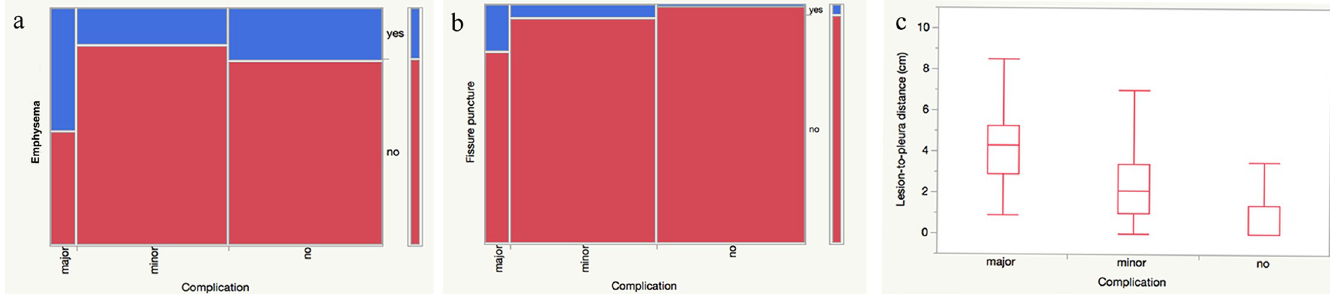
Fig 4. The independent risk factors for major complications in our study (n = 311). Mosaic plot of (a) emphysema and (b) fissure puncture in relation to SIR complications. (c) Box plot of lesion-to-pleura distance in relation to SIR complications.